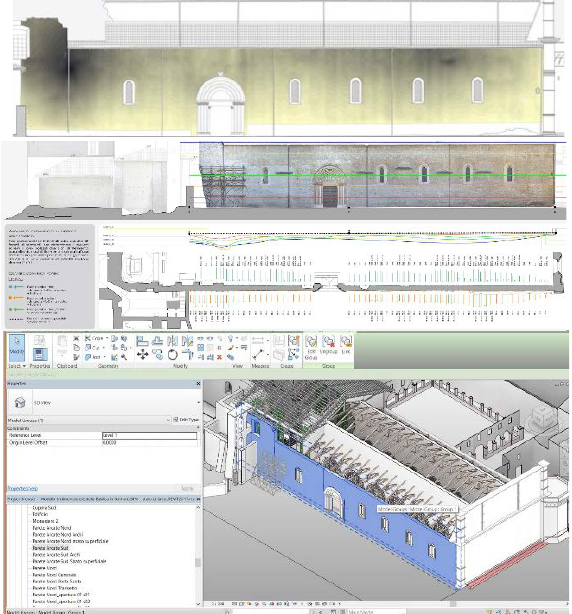
Figure 4. From CAD mapping drawings of Materials and Decay to 3D BIM management. The decay analysis is incorporated into the NURBS-based